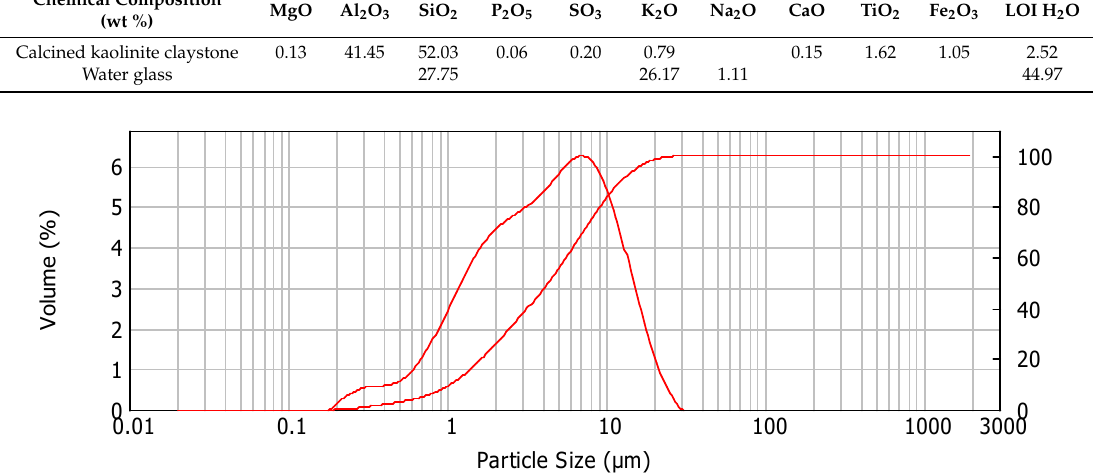
Figure 1. Particle size distribution of the metakaolin prepared from calcined kaolinite claystone measured by laser diffraction.